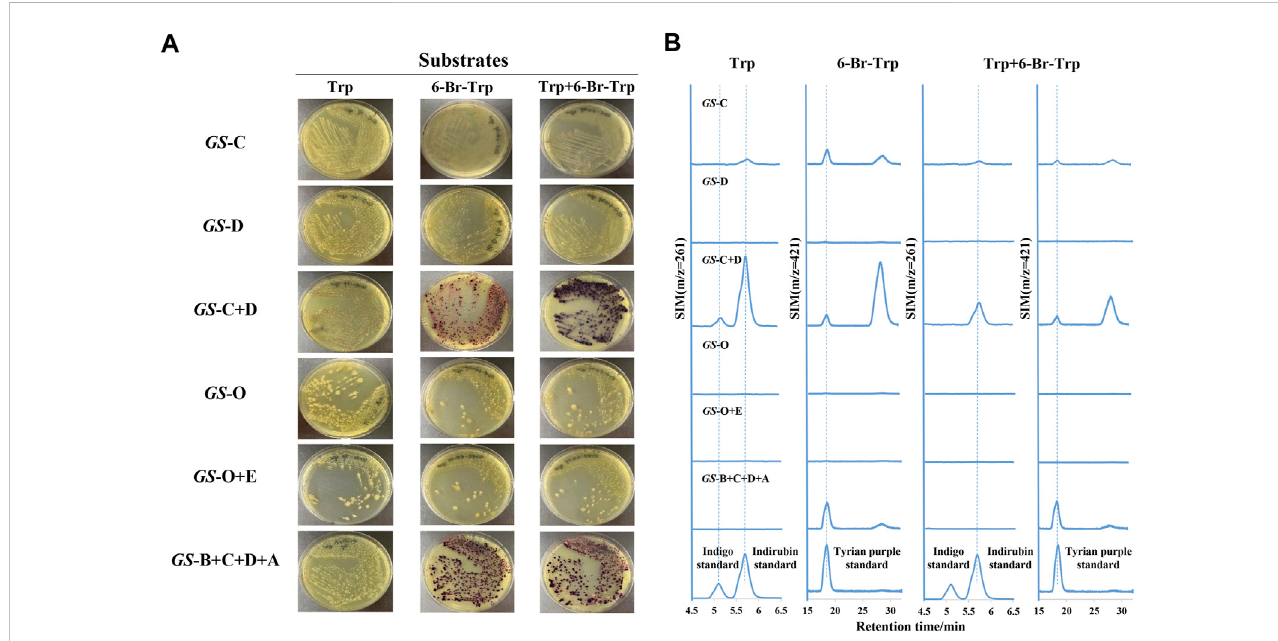
FIGURE 5 Heterologous expression of indole oxygenase genes and indole biodegradation gene cluster in E. coli BL21 (DE3). (A) Engineered E. coli strains with different GS proteins were respectively grown on agar plates with tryptophan and 6-bromo-tryptophan. GS -C, heterologous expression of GS -C; GS -D, heterologousexpression of GS -D; GS -C+ D, heterologous expressionof GS -C and GS -D; GS -O,heterologous expressionof GS -O; GS -O+ E, heterologous expressionof GS -Oand GS -E; GS-B+C+D+A ,andheterologousexpressionof GS -B, GS -C, GS -D,and GS -A. (B) Extractedionchromatogramsforthe standards (the lower) of indigo (m/z = 261), indirubin (m/z = 261), Tyrian purple (m/z = 421), and colonies were collected from E. coli strains expressing different GS proteins on the LB agar plates supplemented with tryptophan and